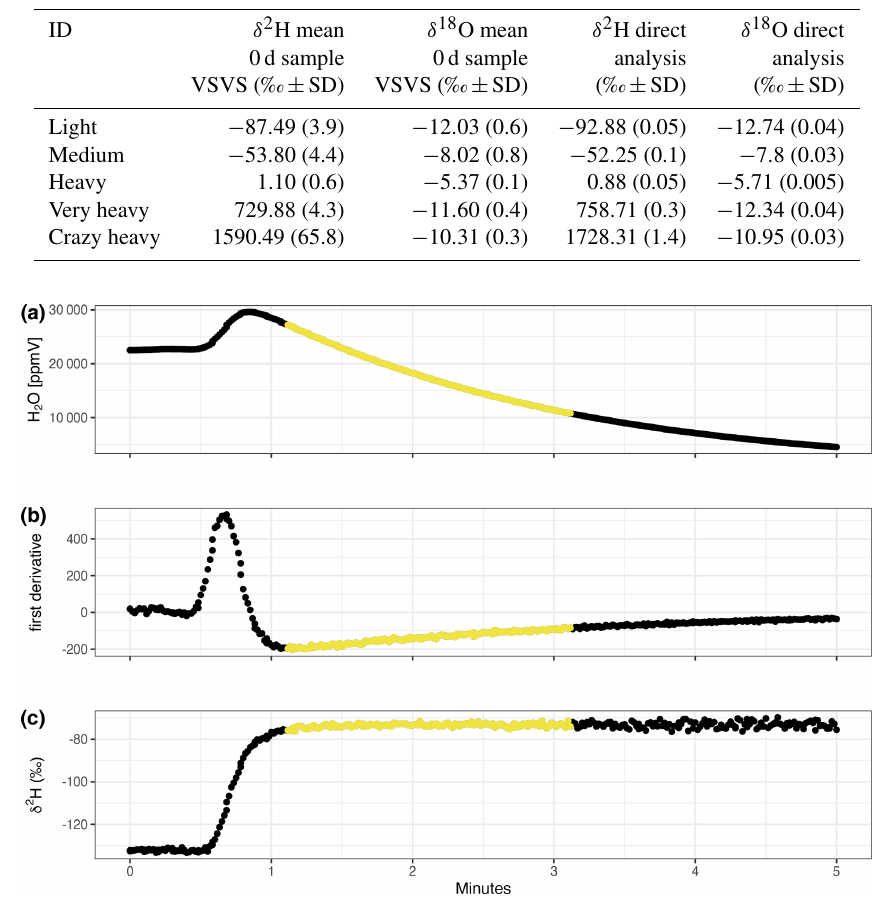
Figure 2. Exemplified measurement data for the “heavy” source over a time period of 5min. Vapour concentration (a) , first derivative of vapour concentration over time (b) , and hydrogen isotopic composition (c) . Following the criteria defined in the main text, we computed the mean of the isotopic composition ( δ 2 H and δ 18 O) over the 2min depicted by the yellow dots in the